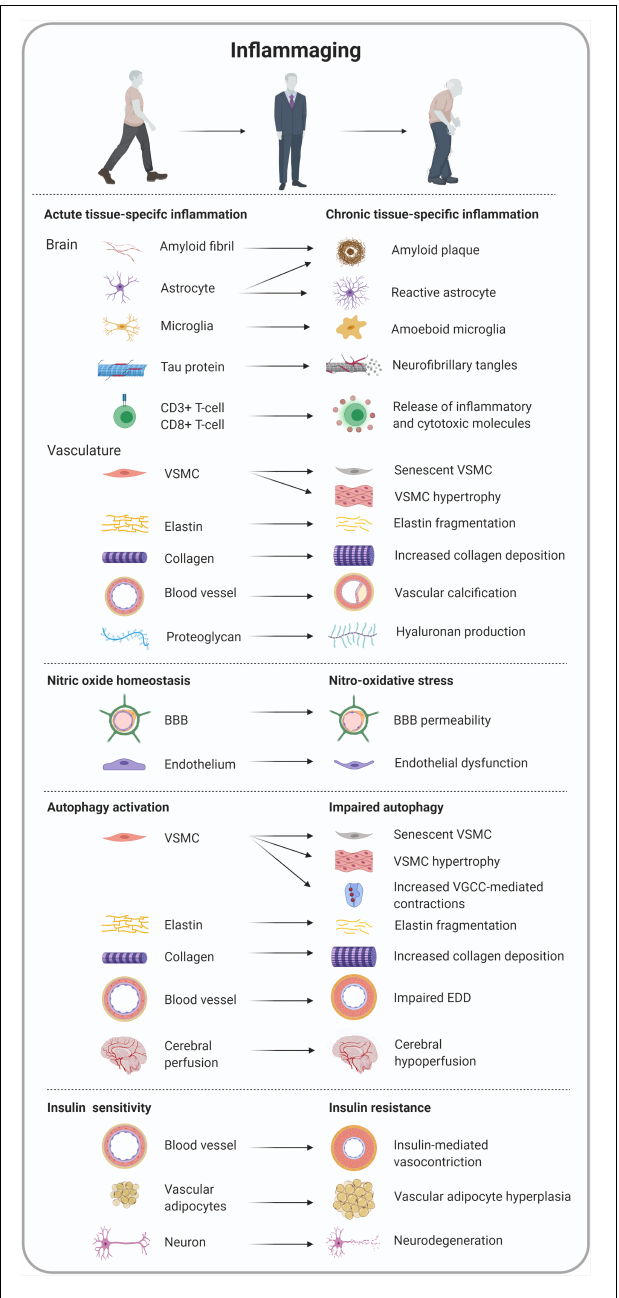
FIGURE 4 | Overview of tissue-specific cell morphology and functionality in inflammaging-related conditions converging arterial stiffness and Alzheimer’s